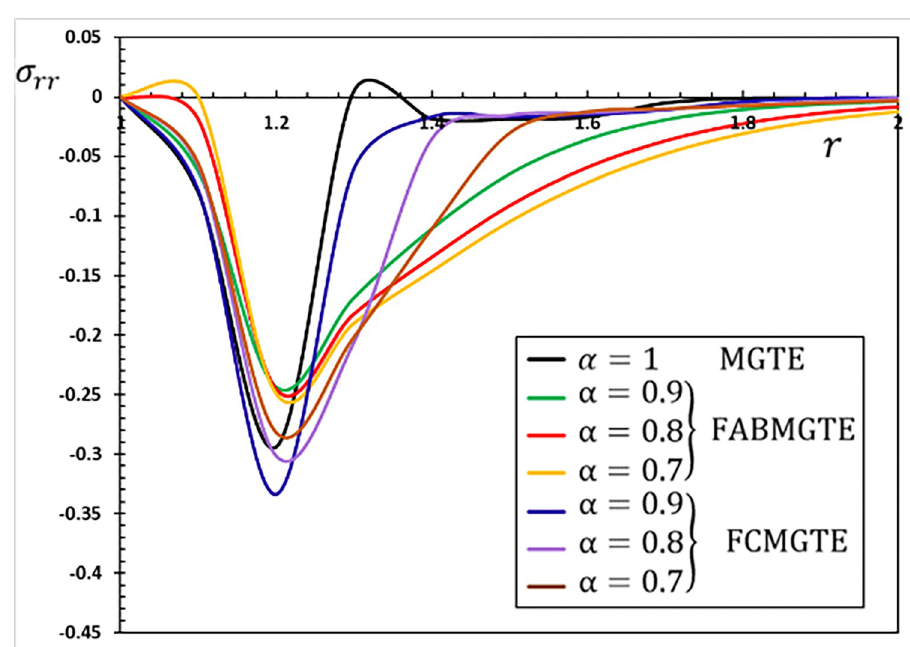
Fig 11. The radial stress variation σ